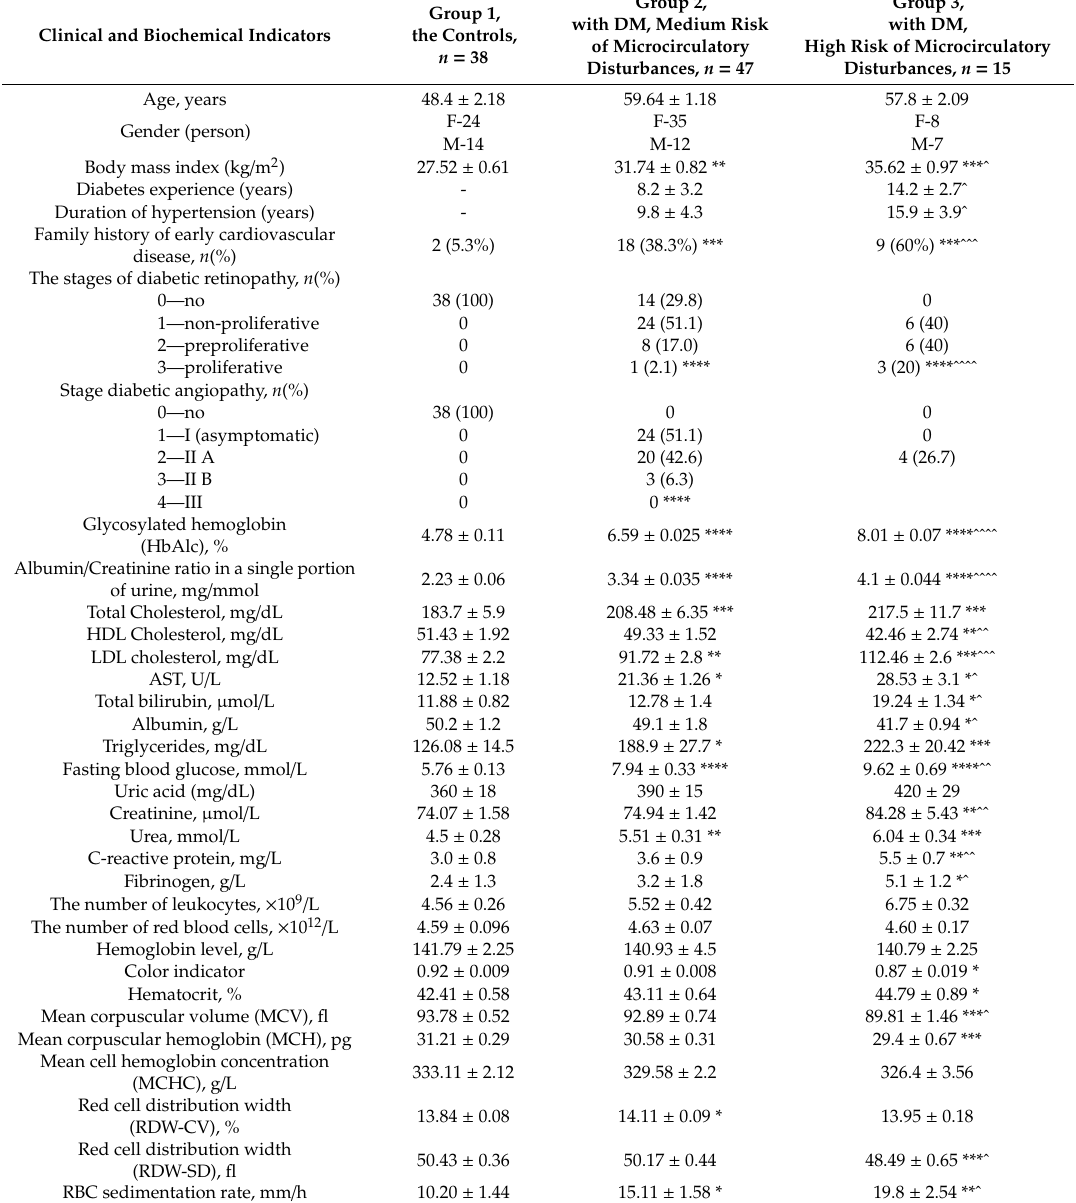
Table 1. Clinical and biochemical data in groups of patients with diabetes with varying degrees of risk of microcirculation disturbances (M ±